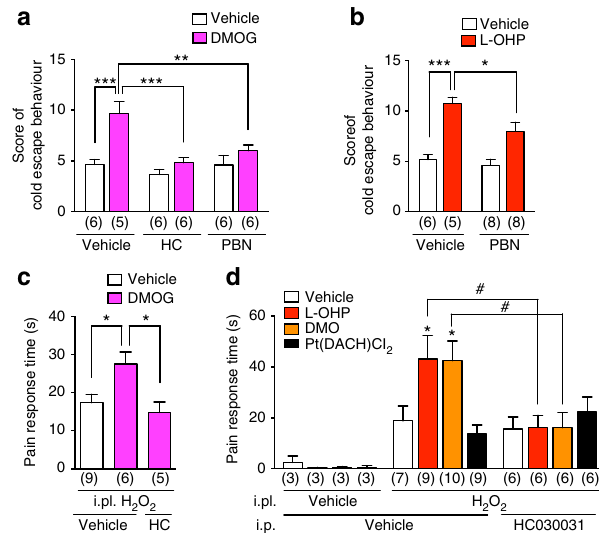
Figure 4 | Inhibiting PHDs contributes to TRPA1-mediated cold hypersensitivity via an enhanced response to ROS. Mice were pre- administered DMOG or L-OHP, and their cold escape behaviour in the cold-plate test ( a , b ) or nocifensive behaviours evoked by intraplantar injection (i.pl.) of H 2 O 2 ( c , d ) were examined. ( a , b ) Effects of DMOG ( a , 400mgkg (cid:2) 1 , i.p.) or L-OHP ( b , 5mgkg (cid:2) 1 , i.p.) pre-administration with or without HC030031 (HC; 100mgkg (cid:2) 1 , i.p.) or PBN (100mgkg (cid:2) 1 , i.p.) on cold escape behaviours. Numbers in parentheses indicate the number of animals in each group. * P o 0.05; ** P o 0.01; *** P o 0.001; two-way ANOVA with Sidak’s post hoc test. ( c ) Effects of DMOG pre-administration with or without HC030031 on H 2 O 2 -evoked nocifensive behaviours. * P o 0.05; one-way ANOVA with Tukey’s post hoc test. ( d ) Effects of L-OHP, DMO (1.7mgkg (cid:2) 1 ) or Pt(DACH)Cl 2 (4.8mgkg (cid:2) 1 ) pre-administration with or without HC030031 on H 2 O 2 -evoked nocifensive behaviours. * P o 0.05 versus i.pl. H 2 O 2 - and i.p. vehicle-treated vehicle group (white bar); # P o 0.05; two-way ANOVA with Tukey’s post hoc test. All data are expressed as mean ± L-OHP and DMO on the amount of hypoxia-inducible factor-1 a (HIF-1 a ), whose degradation is principally regulated by PHDs 33 . Treatment of HEK293 cells with L-OHP (100 m M) or DMO (30 m M) for 24 h increased the amount of HIF-1 a similar to that